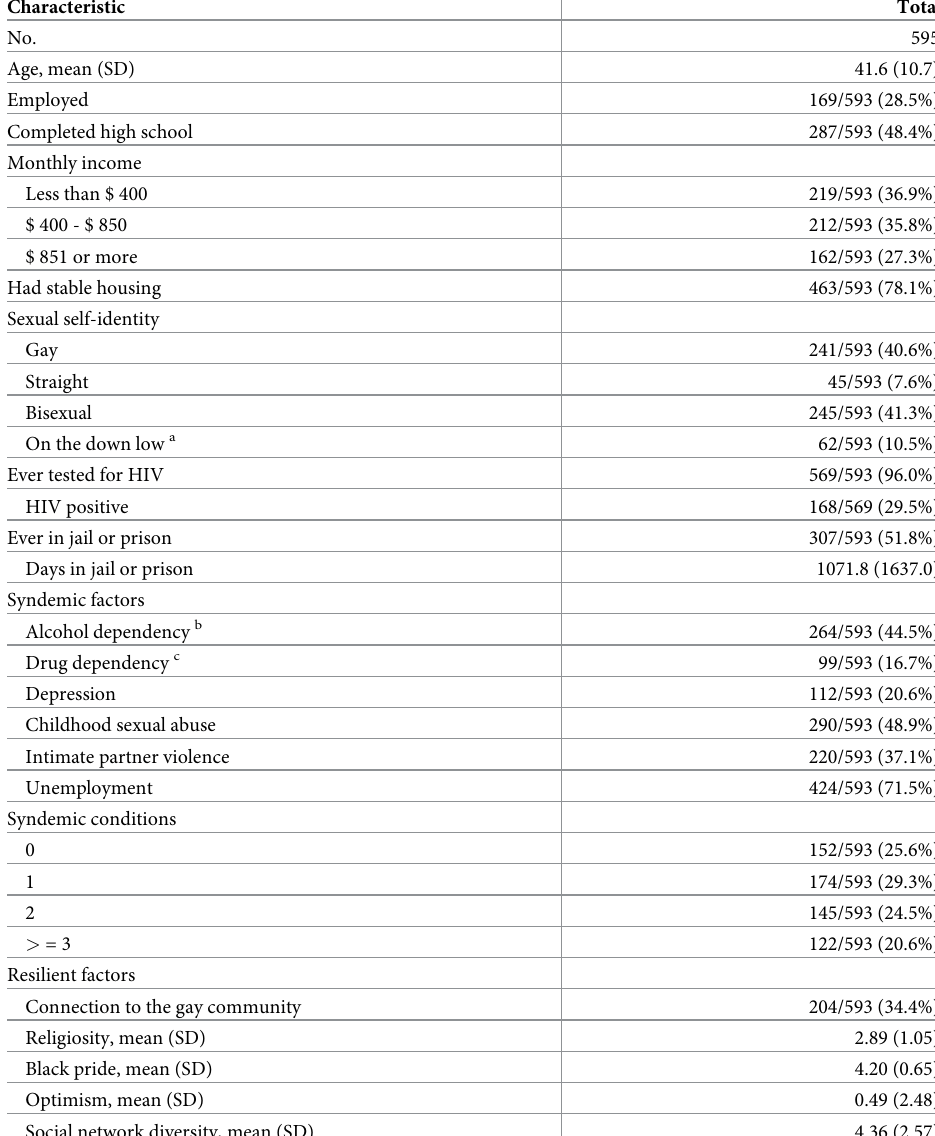
Table 1. Baseline Socio-demographic characteristics of participating African American men, Philadelphia, PA, 2008–2011. Some of the data has been published in the original intervention trial reports [26,